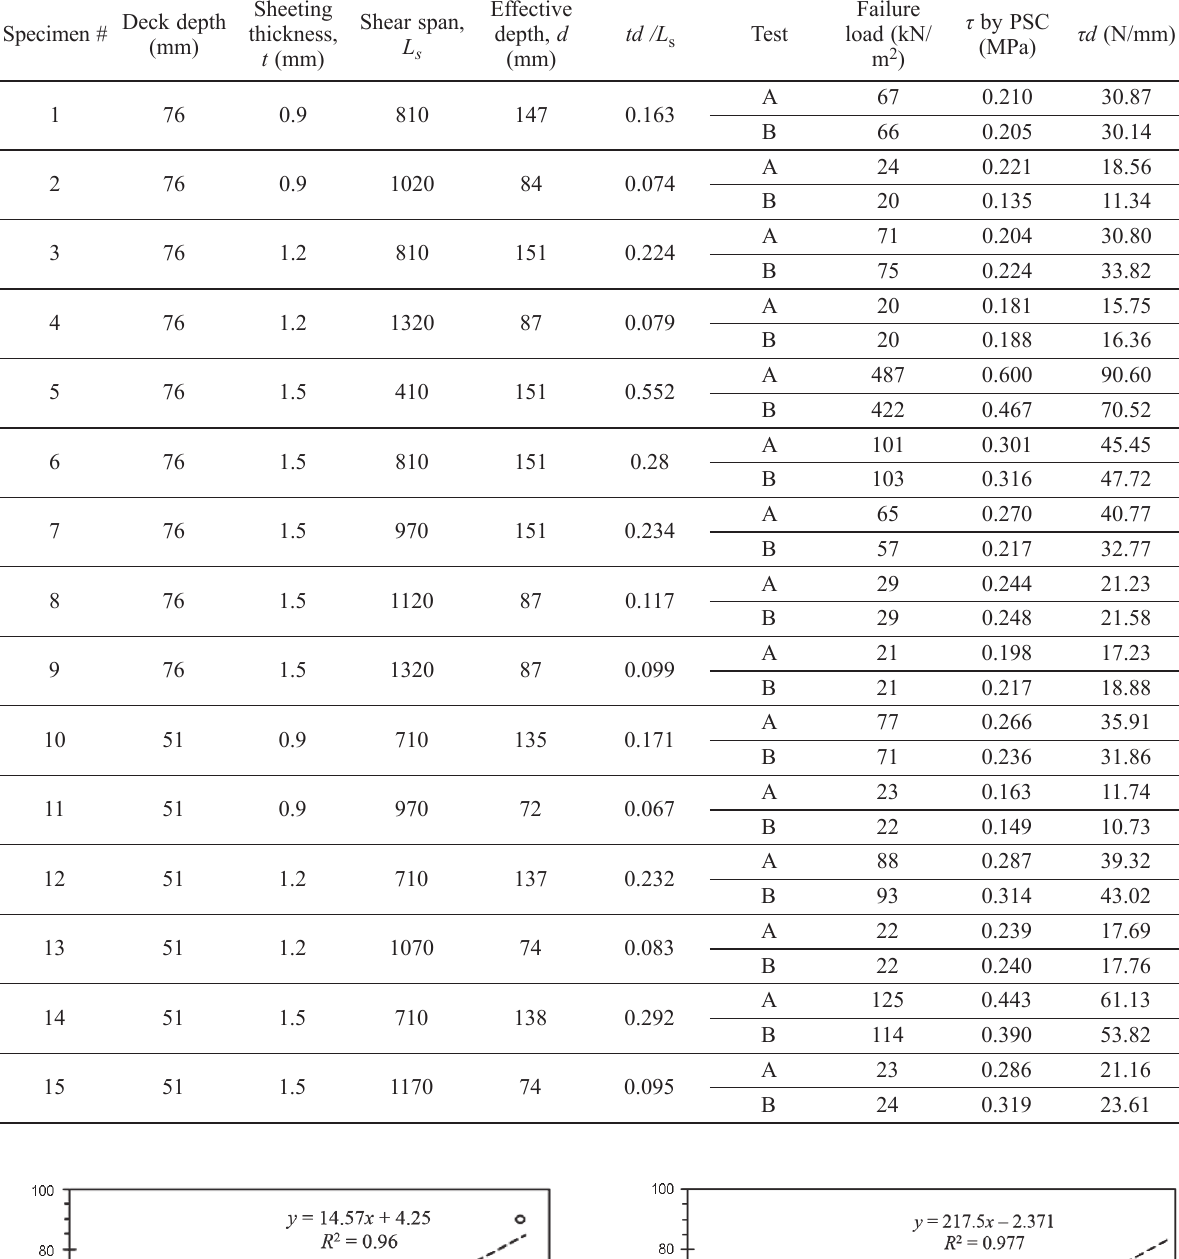
Table 1. Results from elemental tests (Abdullah, Easterling 2007) Deck depth Specimen # (mm)